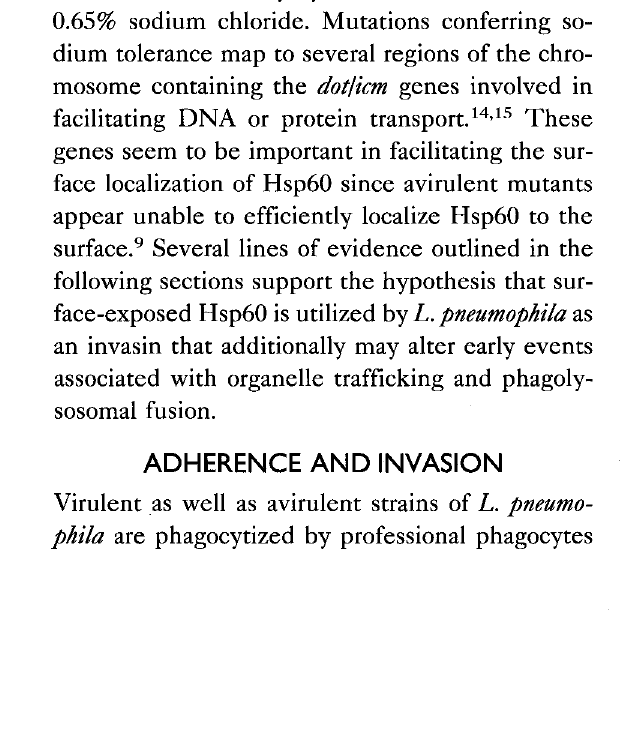
Fig. 2. Parasite-directed receptor-mediated endocytosis of L. pneumophila by HeLa cells. The illustration indicates that Hsp60 binds to specific receptors on the HeLa cells, initiating actin polymerization and endocytosis of the bac- terium into an early endosome. We propose that Hsp60, interacting with the phagosome membrane, alters signal transduction networks that would ordinarily traffic the bac-